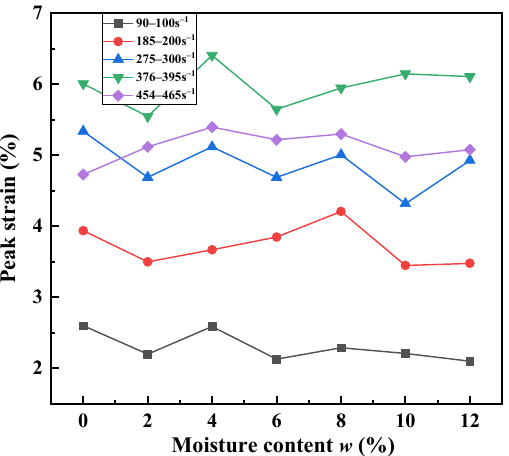
Figure 19. Variations in peak stress with moisture content for sand specimens at different strain rates.